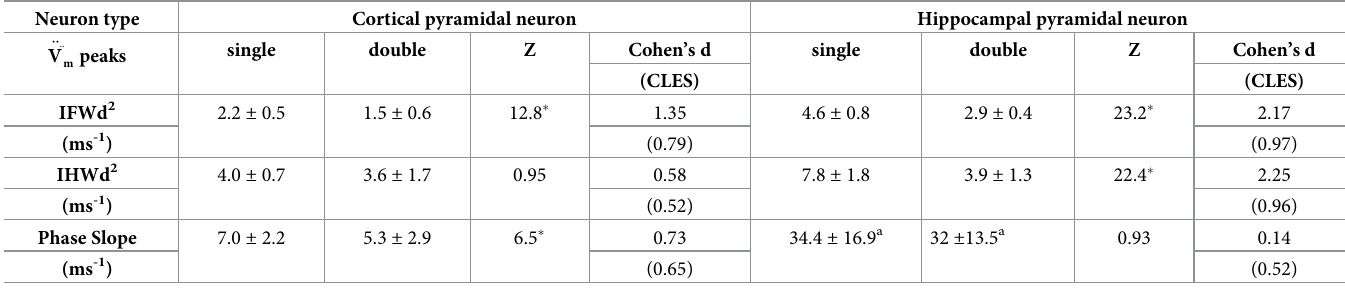
Z-score from Mann-Whitney test were used to compare AP waveform, Cohen’s d and common language effect size (CLES) were used to measure the effect size. a using piecewise cubic interpolation. � the difference is significant (p <